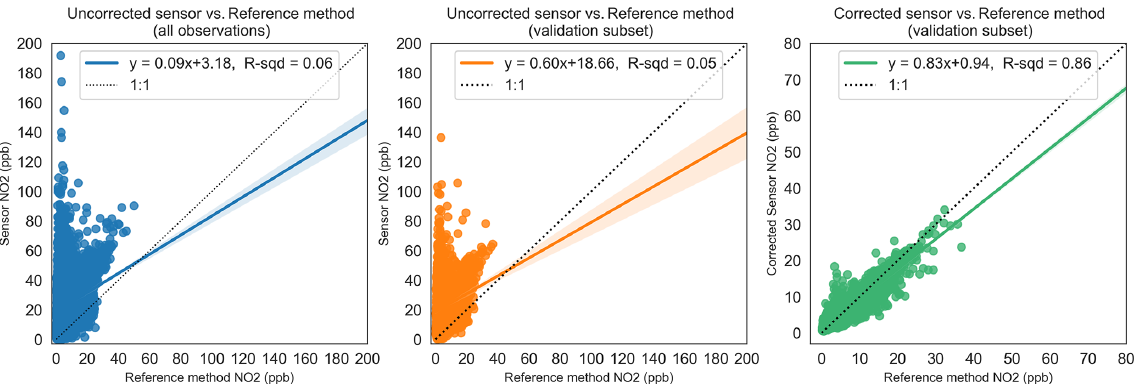
Figure 6. Relationship between uncorrected sensor, RF-model-corrected sensor and reference method observations for NO 2 . The dotted line shows the unity slope. R-sqd: R 2 .